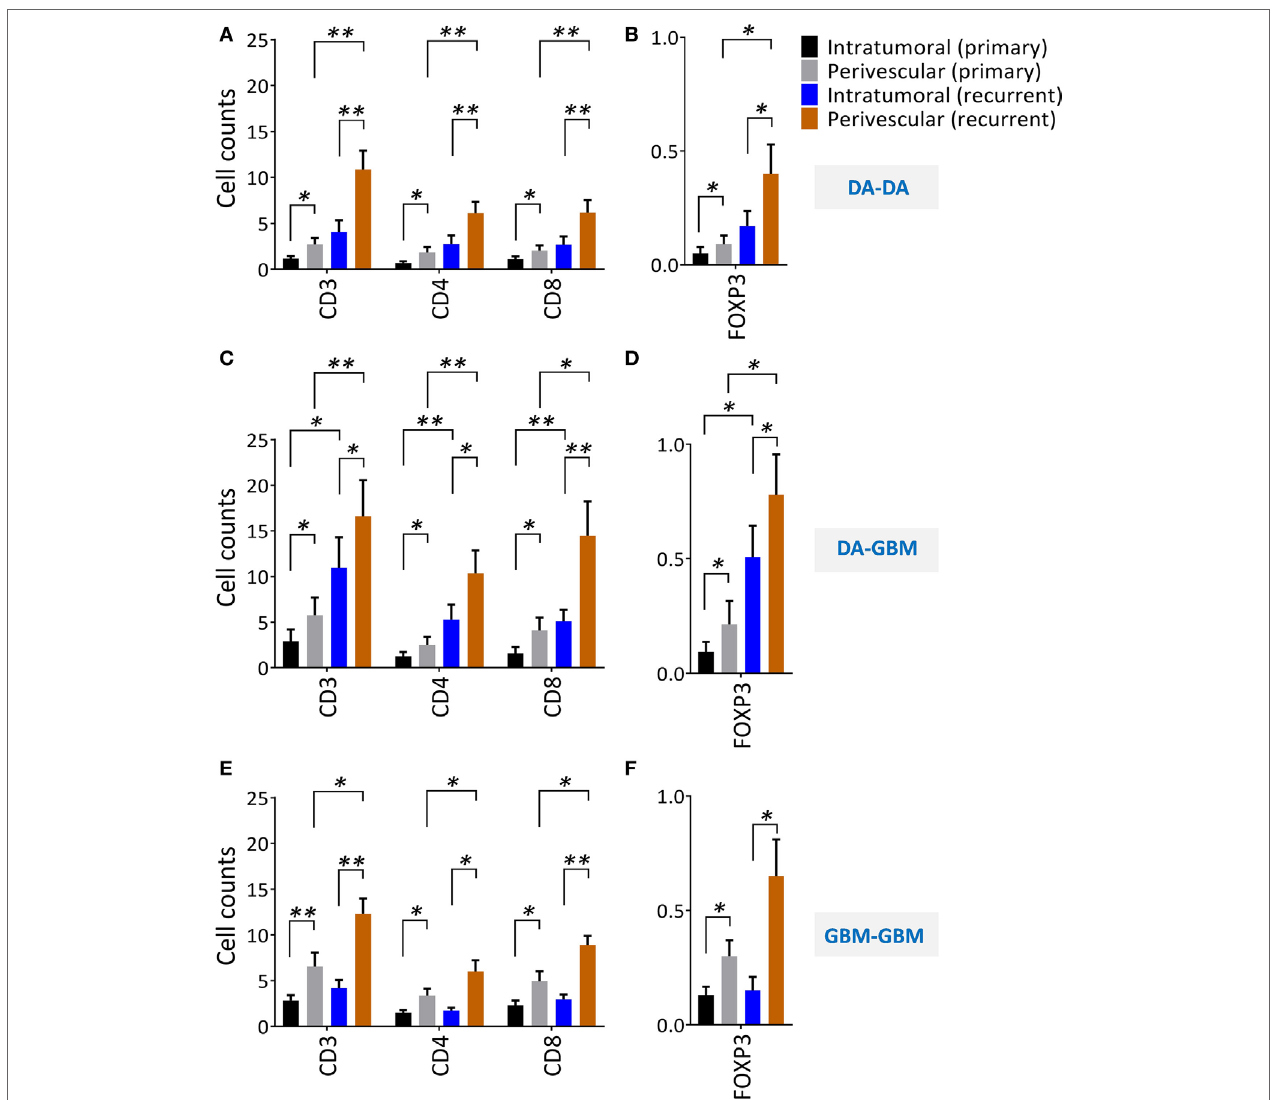
FigUre 4 | A significant increase of perivascular tumor-infiltrating lymphocytes after tumor recurrence. Perivascular and intratumoral infiltrating CD3 + , CD4 + , CD8 + , and Foxp3 + T cells before and after recurrence were evaluated from randomly selected consecutive 10 high powered fields (HPFs). (a,B) diffuse astrocytomas (DA)–DA, (c,D) DA–GBM, and (e,F) GBM–GBM. Same scales are plotted for all the recurrent groups. The significances were determined respectively using paired t